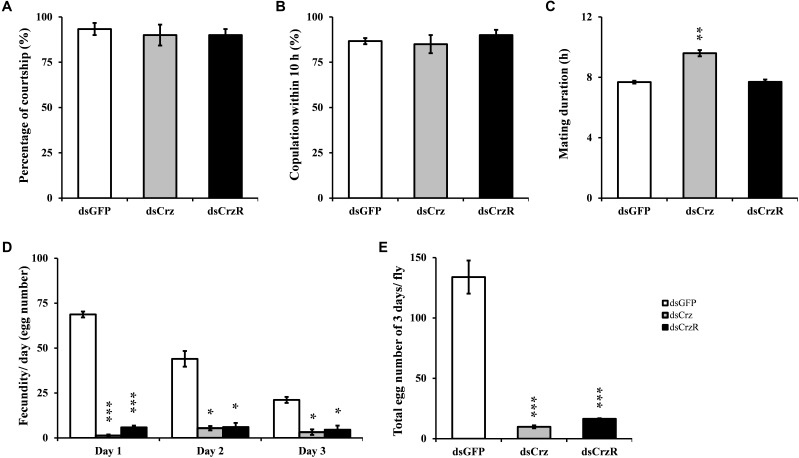
Effect of RNAi-mediated Crz or CrzR knockdown on mating behavior and fertility in the male adult of B. dorsalis. Proportion of couples courting (A), copulation (B), the corresponding mating duration (C) and the fecundity (D,E). dsGFP-, dsCrz-, or dsCrzR-injected male was crossed with a normal female. The data are presented as means ± SE based on three independent experiments. ∗p < 0.05, ∗∗p < 0.01, ∗∗∗p < 0.001.